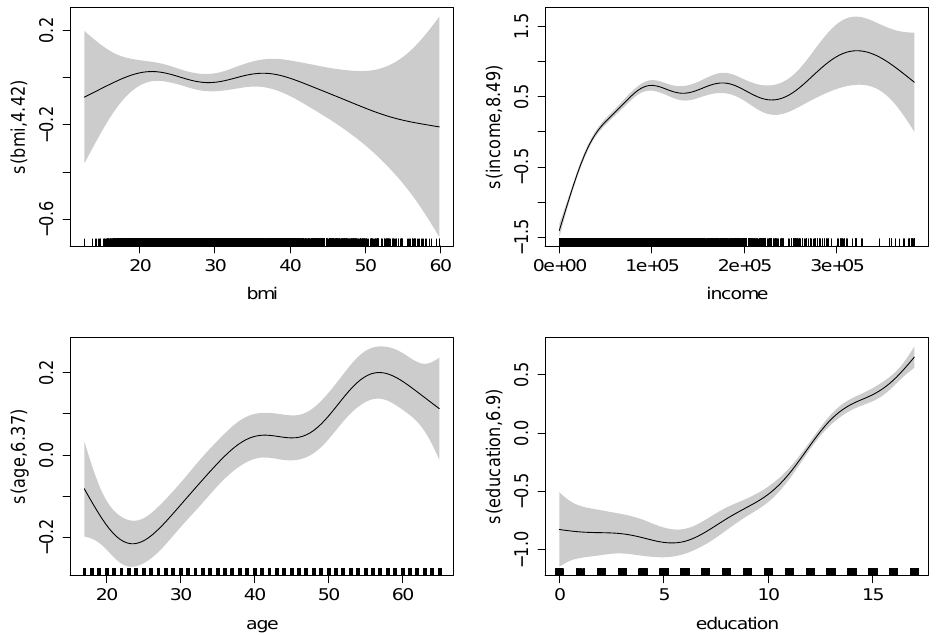
Figure 1: Treatment equation: smooth function estimates and associated 95% point-wise confidence intervals obtained by fitting the Clayton180 copula model on the 2008 MEPS data. Results are plotted on the scale of the additive predictor. The jittered rug plot, at the bottom of each graph, shows the covariate values. The numbers in brackets in the y-axis captions are the edf of the smooth curves.